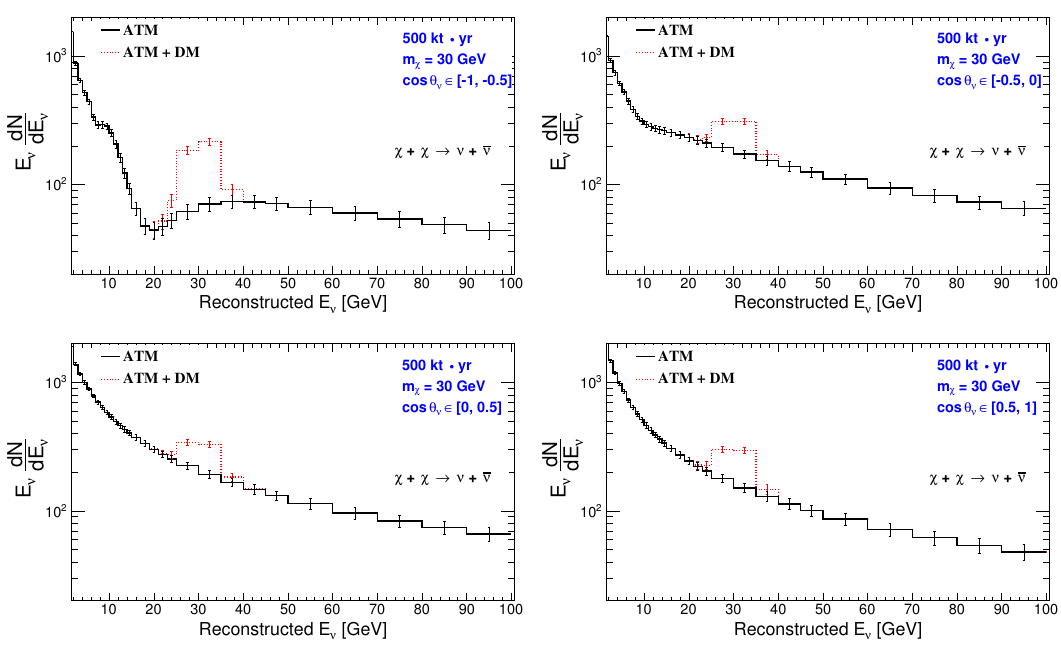
Figure 4. Event spectra of atmospheric (cid:23) (cid:22) (denoted by ATM) are shown by the black solid lines. The predicted event distributions coming from atmospheric (cid:23) (cid:22) and dark matter originated neutrino (ATM + DM) are shown in red dotted lines for di(cid:11)erent cos (cid:18) ranges using 500 kt (cid:1) yr exposure of the MagICAL detector. The signal (DM) is coming from 30 GeV annihilating DM particles here. The mass ordering is taken as NO. The (cid:31)(cid:31) ! (cid:23) (cid:22) (cid:23) cross-section is arbitrarily chosen to < (cid:27)v > = 3 : 5 (cid:2) 10 (cid:0) 23 cm 3 s (cid:0) 1 to have visual clarity.